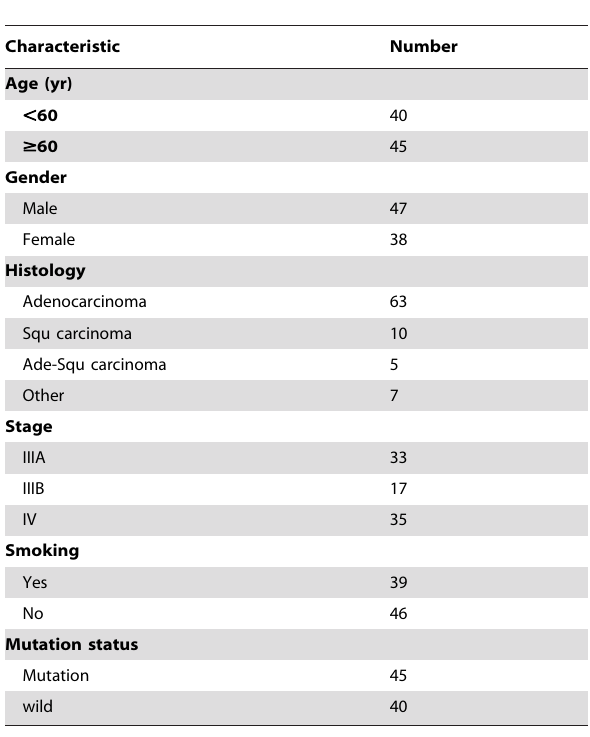
Table 1. Patient